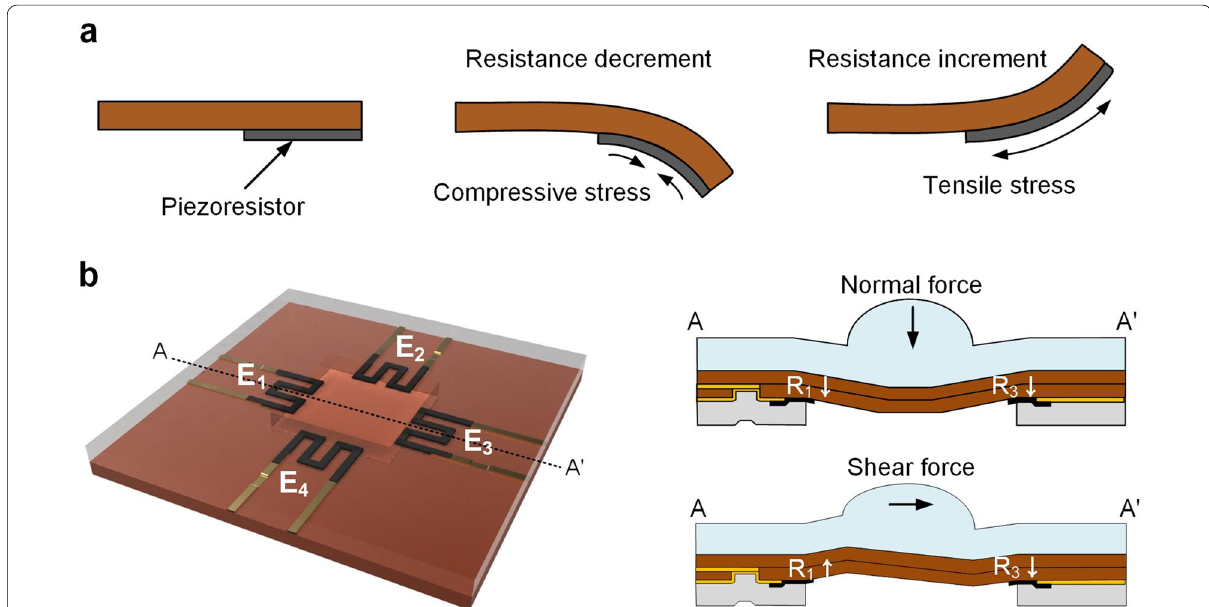
Fig. 2 Sensing mechanism of the proposed multi‑directional tactile sensor. a Change in electrical resistance of piezoresistor with respect to applied stress. Compressive and tensile stresses cause decrease and increase in the resistance of the piezoresistor, respectively. b Operating principle for normal and shear force detections. The resistances of the four piezoresistors change identically under a normal force. In contrast, when a shear force is applied, the resistance of each piezoresistor changes